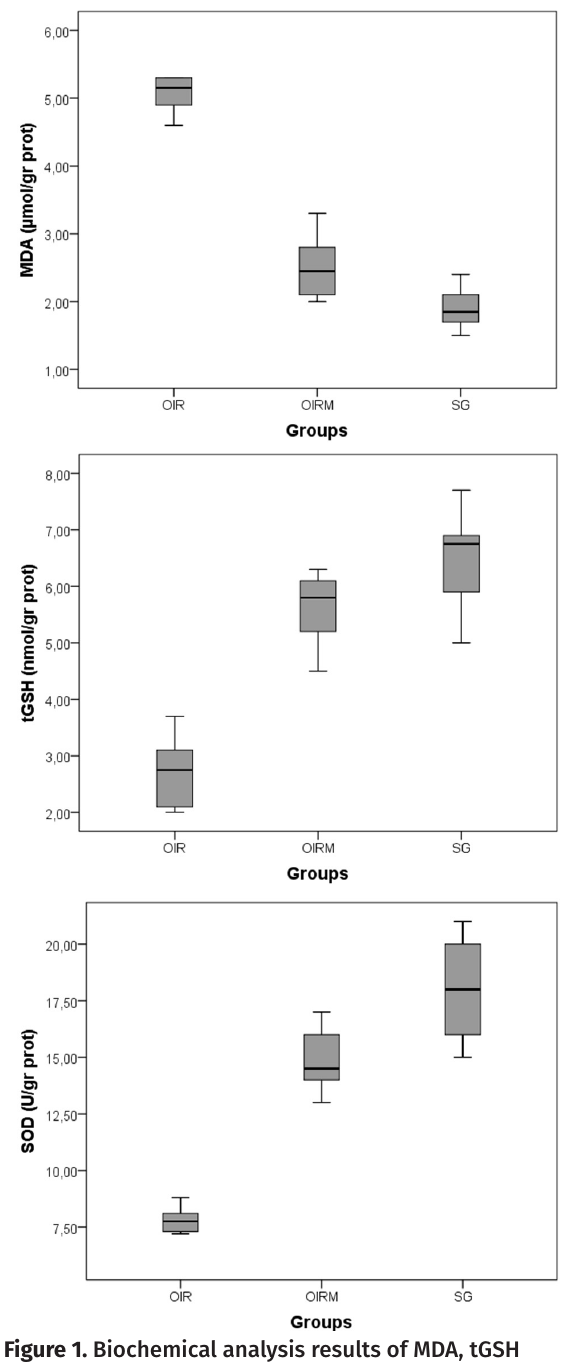
Figure 1. Biochemical analysis results of MDA, tGSH and SOD parameters. Values are expressed as mean ±